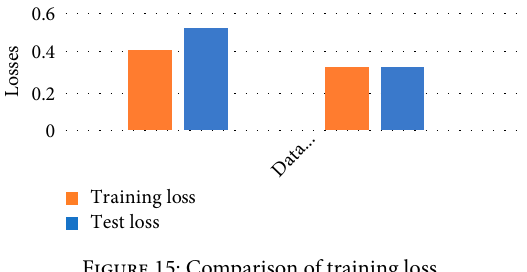
Figure 15: Comparison of training loss.